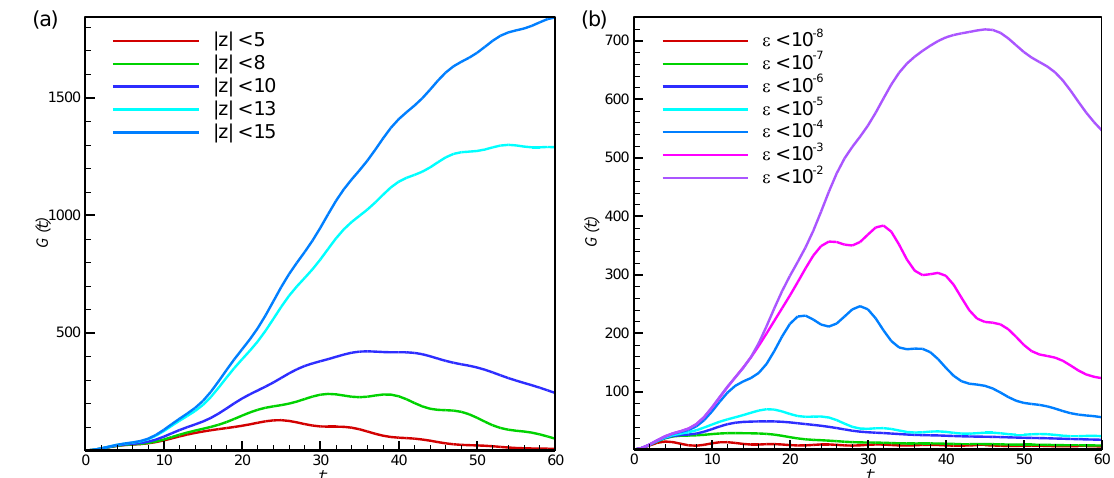
Figure 1. Comparison of growth functions calculated using the singular value decomposition (SVD) method based on extracted vectors ( a ) located in | z | < L, i.e., vanishing outside the shear zone and ( b ) corresponding to the values of their pseudospectrum, for Ri = 0.9, Re = 1000, α = 0.5, β = 0.